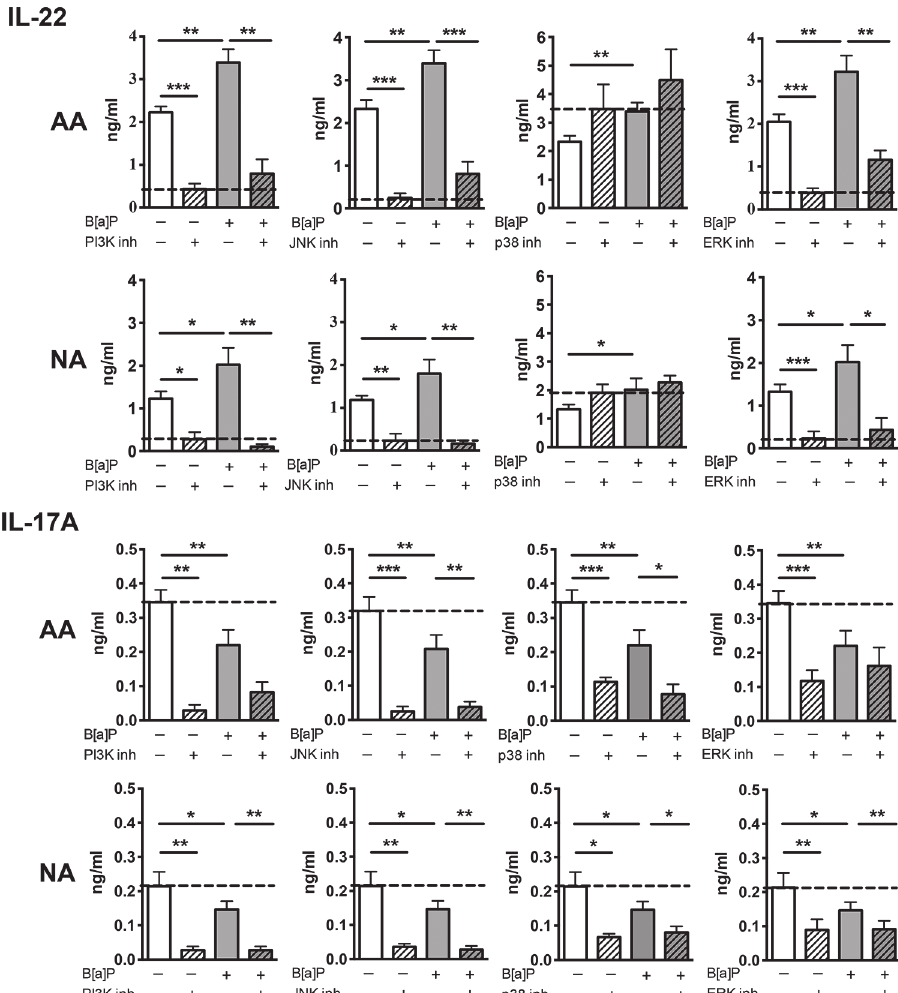
Fig 6. Effects of kinase inhibitors on IL-22 and IL-17A secretion. Activated peripheral blood mononuclear cells from nonallergic (NA) subjects (n = 8) and allergic asthmatic (AA) patients (n = 8) were incubated or not with PAH and with or without inhibitors of kinases for 72hr, and cytokine production was evaluated by ELISA in the supernatants. Results are expressed as mean ± SEM. * P < .05, ** P < .01 *** P < .001. The dotted line is set on the level of inhibitor-treated control cells for IL-22 and of control cells for IL-17 and indicates the level to achieve for complete dependence upon the pathway